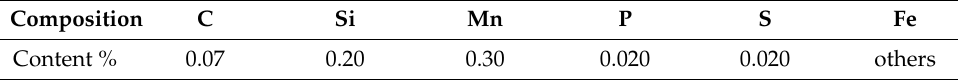
Table 1. The composition of ISO: HR2( σ s195) steel.